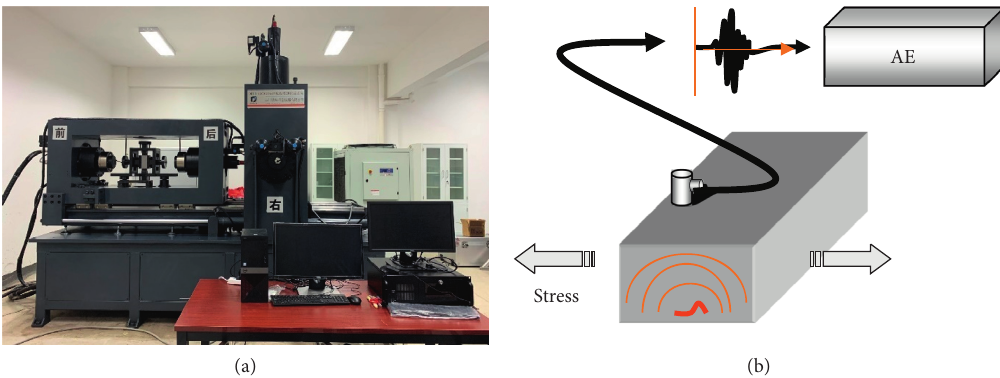
Figure 1: Test system simulation of earth interior atmosphere and sound. (a) Earth interior atmosphere and sound experiment host. (b) Schematic of acoustic emission detection system.